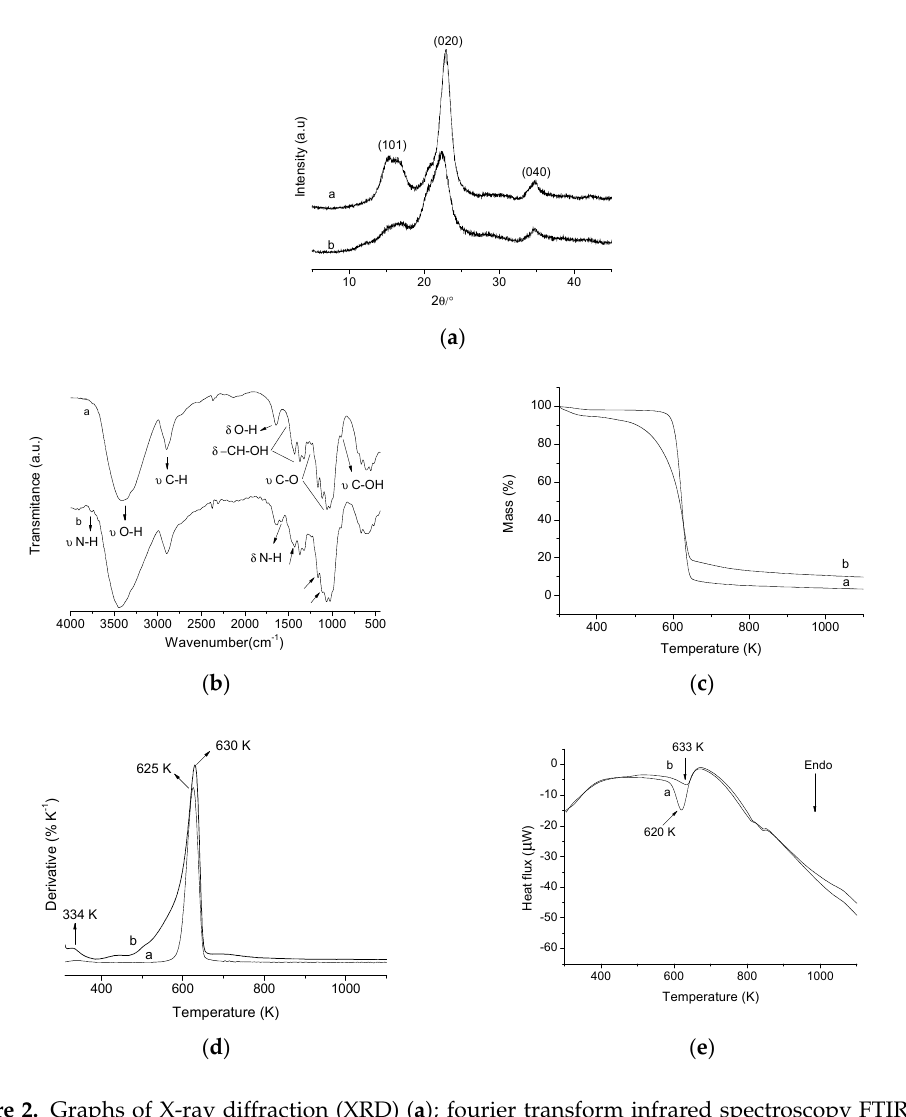
Table 1. Percentage of carbon and nitrogen from the polymer and the respective numbers of moles from pure and modified (CN) polymer. Element